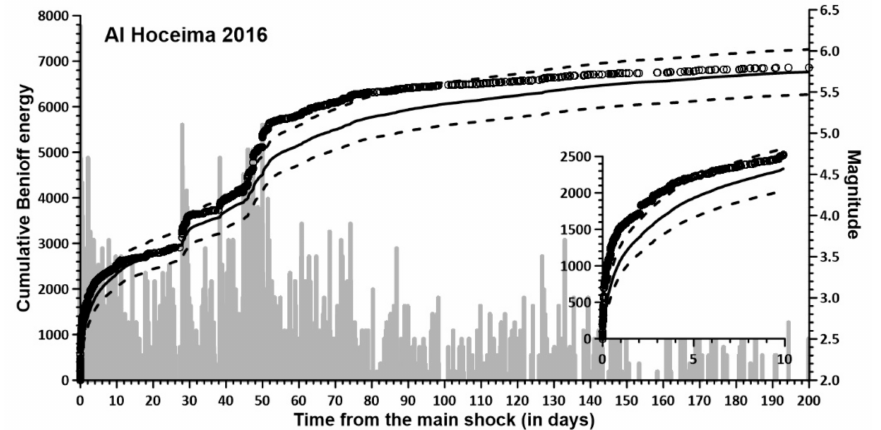
Figure 12. Cumulative released energy for the three sequences. Circles: observed values. Lines: mean σ fitted model. Magnitudes of the events included in the sequences are also depicted. The inset shows the first ten days of the series.